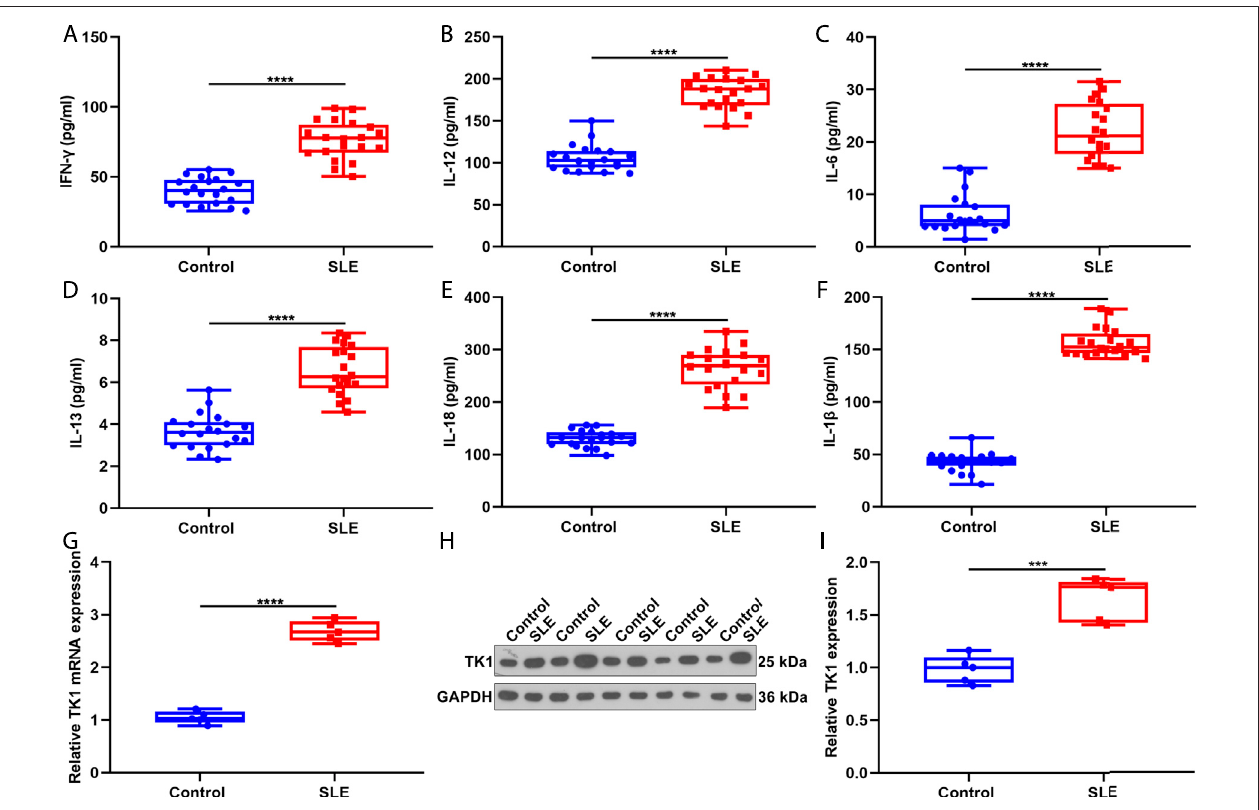
FIGURE 7 | Activation of in fl ammatory response in SLE and up-regulation of TK1 in SLE BMSCs. (A – F) Serum levels of (A) IFN- γ , (B) IL-12, (C) IL-6, (D) IL-13, (E) IL-18 as well as (F) IL-1 β were measured in twenty SLE patients and twenty controls through ELISA. (G – I) TK1 mRNA expression was tested in BMSCs from fi ve SLE patients and fi ve controls through (G) RT-qPCR and (H,I) western blotting. *** p < 0.001; **** p <